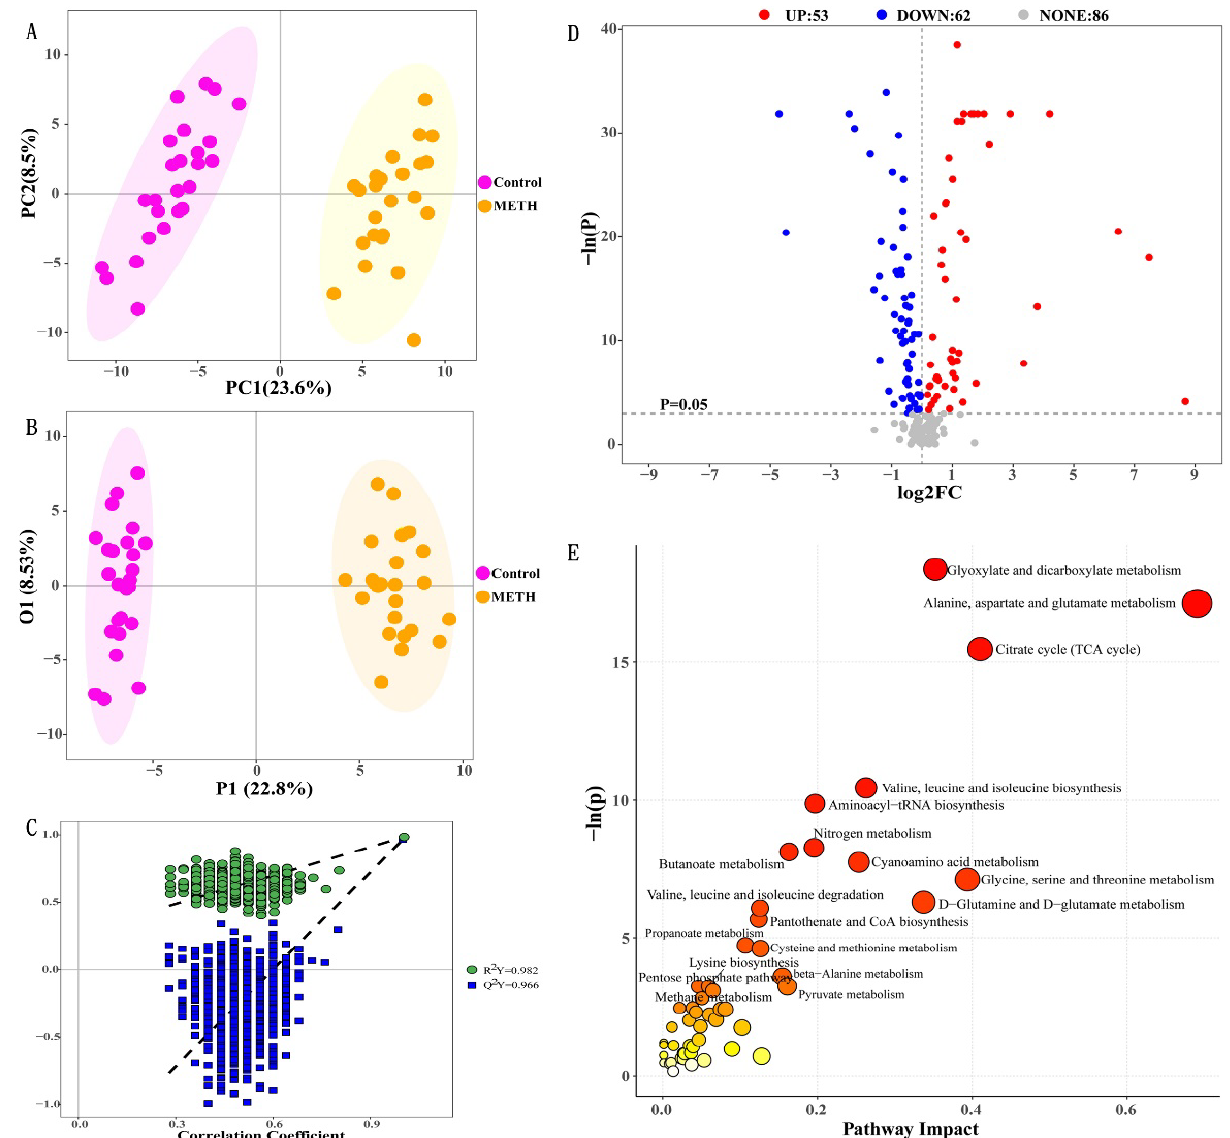
Figure 1. Differential metabolic profiles between the METH and control groups. ( A ) PCA score plot data of healthy controls (pink) versus METH dependents (yellow), ( B ) OPLS-DA scores plot data of healthy controls (pink) versus METH dependents (yellow), ( C ) permutation plot of the OPLS-DA models, ( D ) volcano plot of 115 significantly altered metabolites ( p < 0.05), and ( E ) bubble plot of altered metabolic pathways analysis obtained via KEGG analysis and the comparison of METH with control groups.